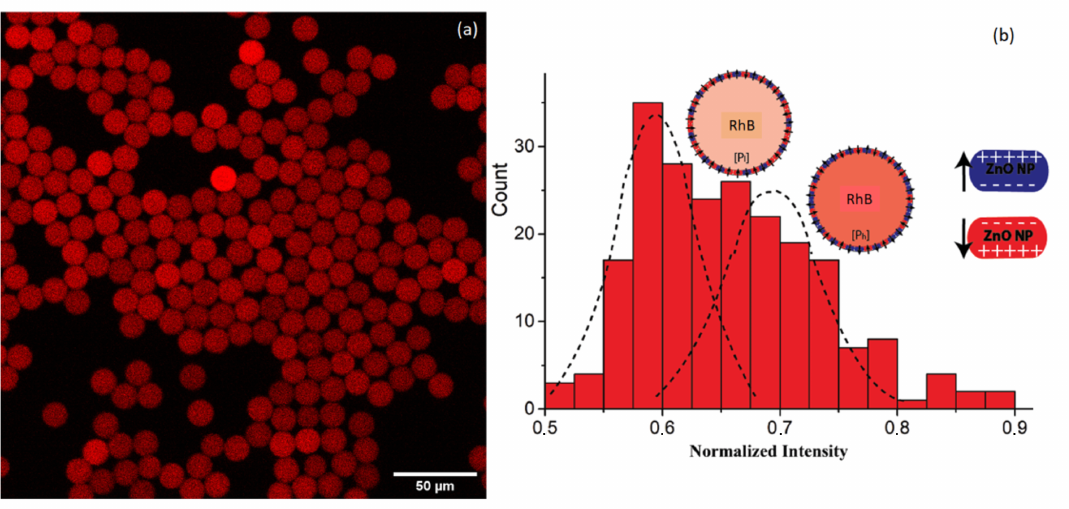
Figure 8. ( a ) Confocal fluorescence showing a non homogeneous distribution of rhodamine B dye in different ZnO microcapsules and ( b ) the corresponding distribution of normalized fluorescence intensity showing two populations of